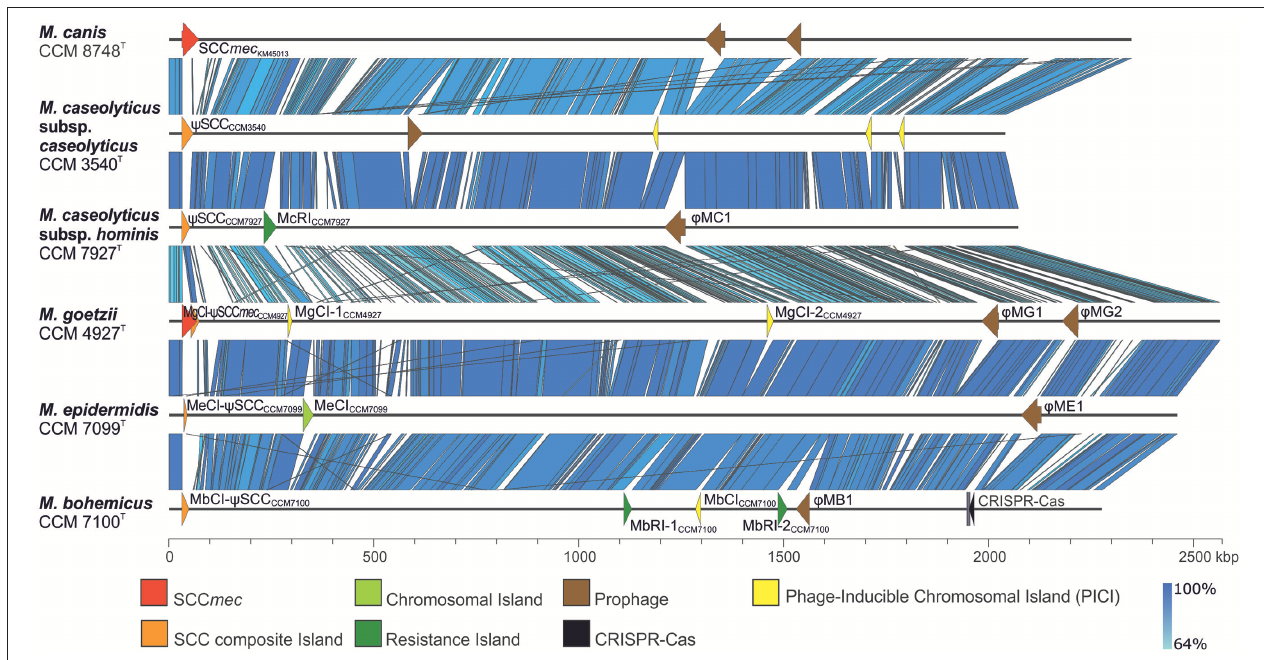
FIGURE 3 | Whole-genome comparison of human macrococci and Macrococcus caseolyticus subsp. caseolyticus subsp. nov. CCM 3540 T and Macrococcus canis CCM 8748 T (GenBank accession number CP021059) with highlighted variable genetic elements. Variable genetic elements are color-coded according to the